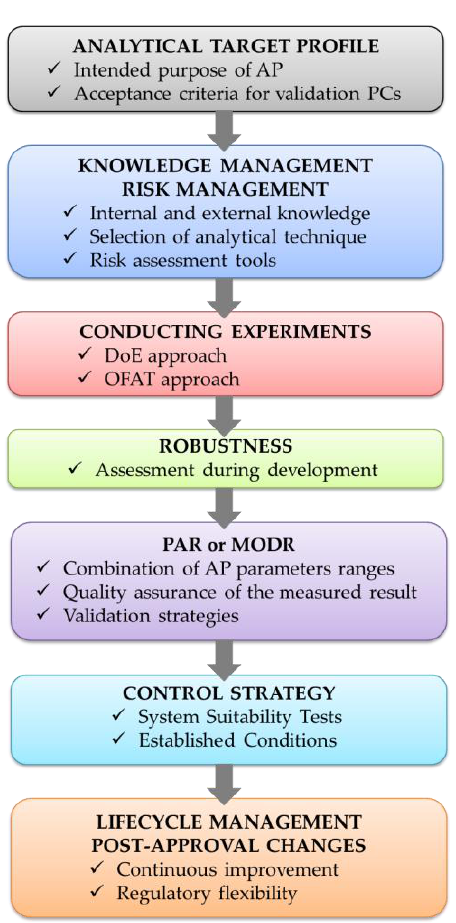
Figure 3. The key steps of ICH Q14 enhanced